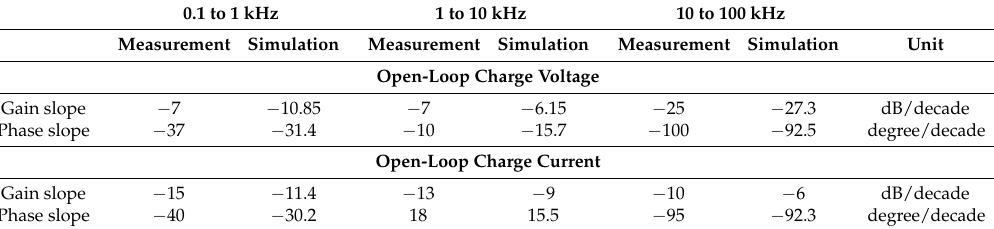
Figure 21. Bode plot measurements: ( a ) G ov and ( b ) G oc . Table 8. Gain and phase